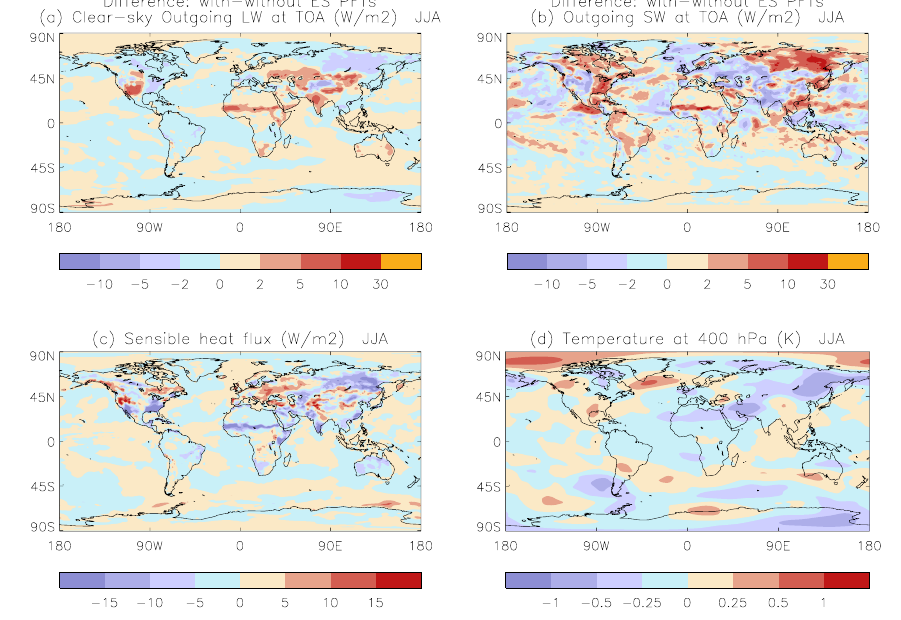
Fig. 11. As Fig. 10 but for June, July, August